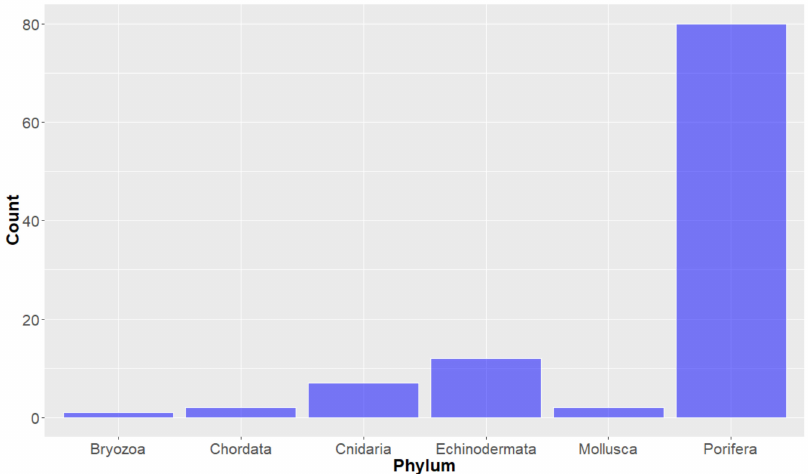
Figure 3. Number of natural products isolated from the Animalia Kingdom, by